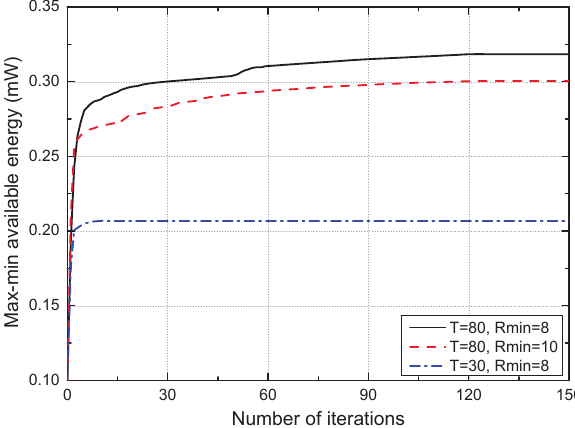
Figure 2. Convergence of the proposed scheme.